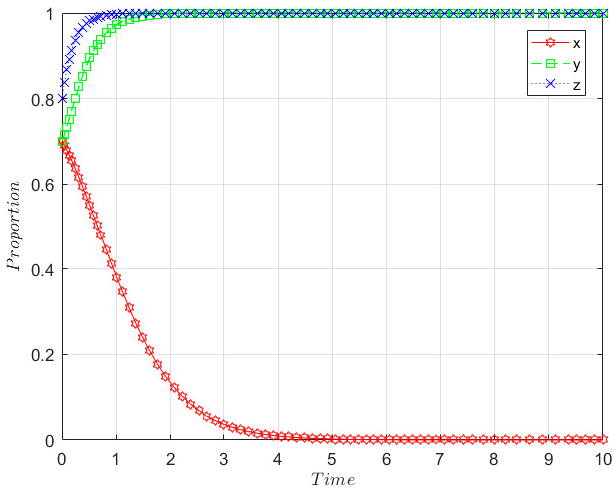
Figure 5. Evolution path of stability point E 7 (0, 1, 1) in the mature development stage.